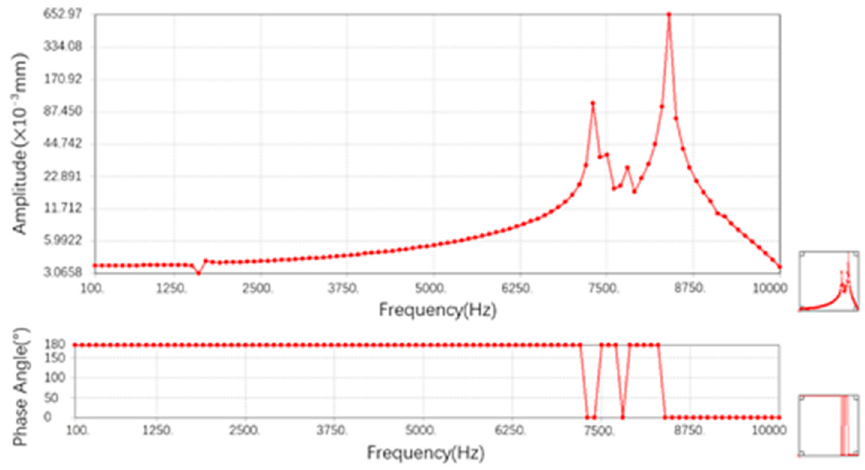
Figure 8. Harmonic response results from 0 Hz to 10 000 Hz.